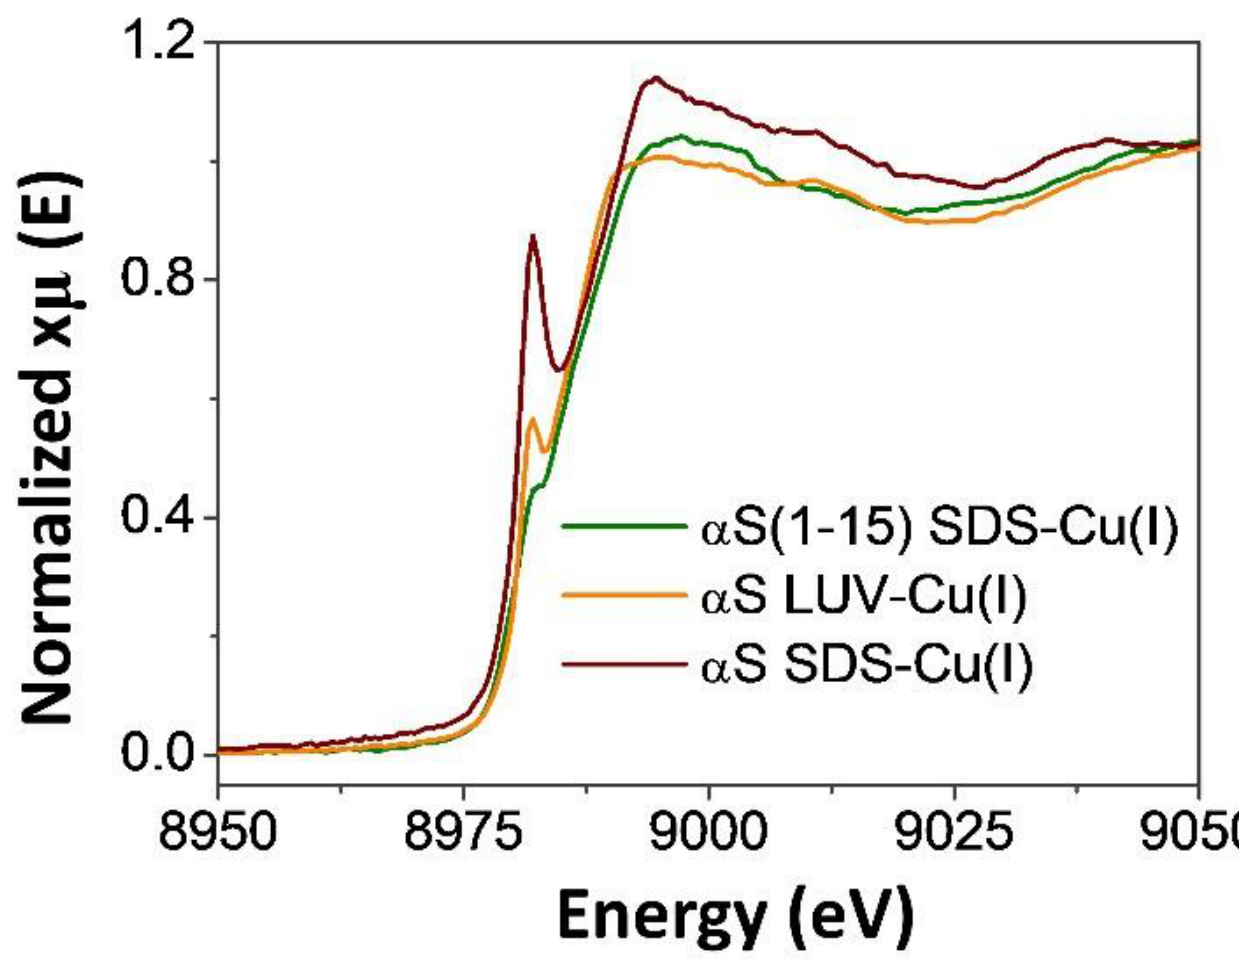
Figure 2. Cu K-edge XANES spectra of the membrane-bound α Syn 1–140 and α Syn 1–15 Cu + complexes. αSyn 1 – 140 500 μM, αSyn 1 – 15 500 μM, Cu 2+ 250 μM, SDS 50 mM, 125:1 lipid:protein ratio, phosphate buffer 20 mM pH = 7.4.